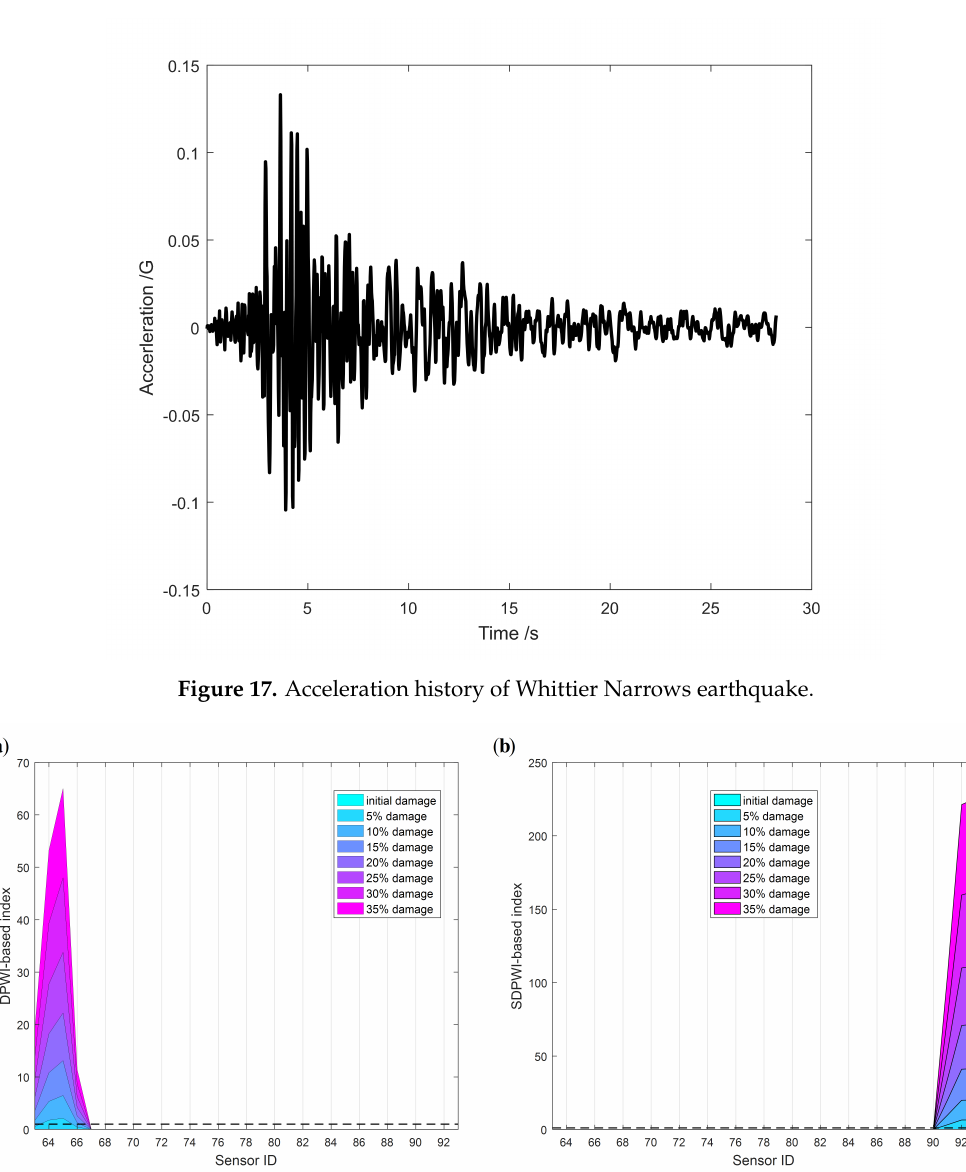
Figure 18. Damage identification results of the CCGB under Whittier Narrows earthquake: ( a ) Damage I, ( b ) Damage